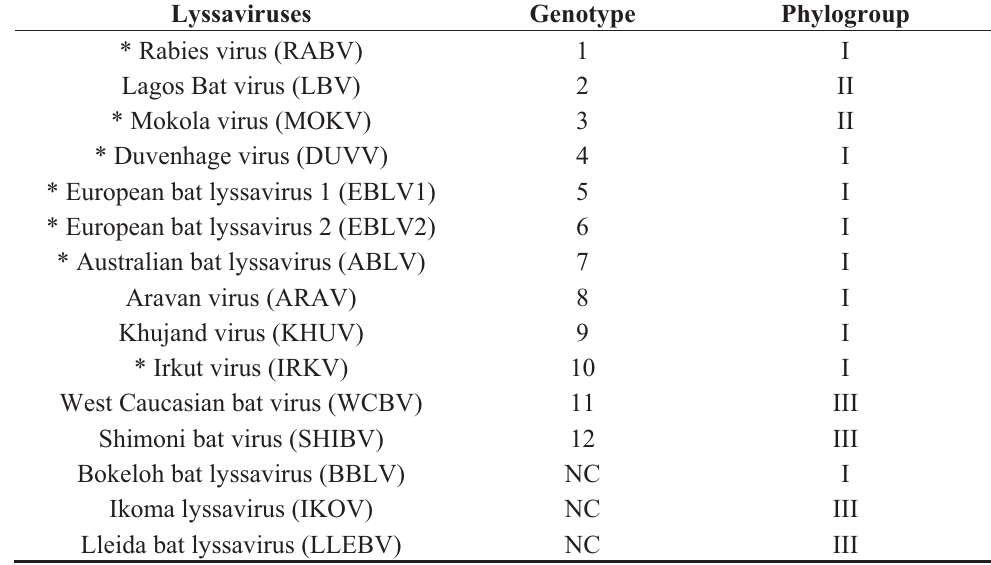
Table 1. Genotype and phylogroup classifications for the lyssaviruses. NC, not classified; these viruses are not yet classified as distinct lyssavirus species (genotypes) according to the International Committee on the Taxonomy of Viruses (ICTV) [35]. *, Human cases have been